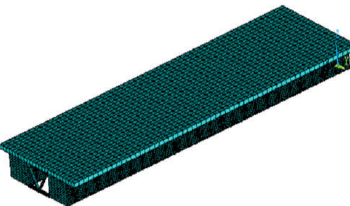
Figure 6. The finite element analysis model of the experimental CW-SBS